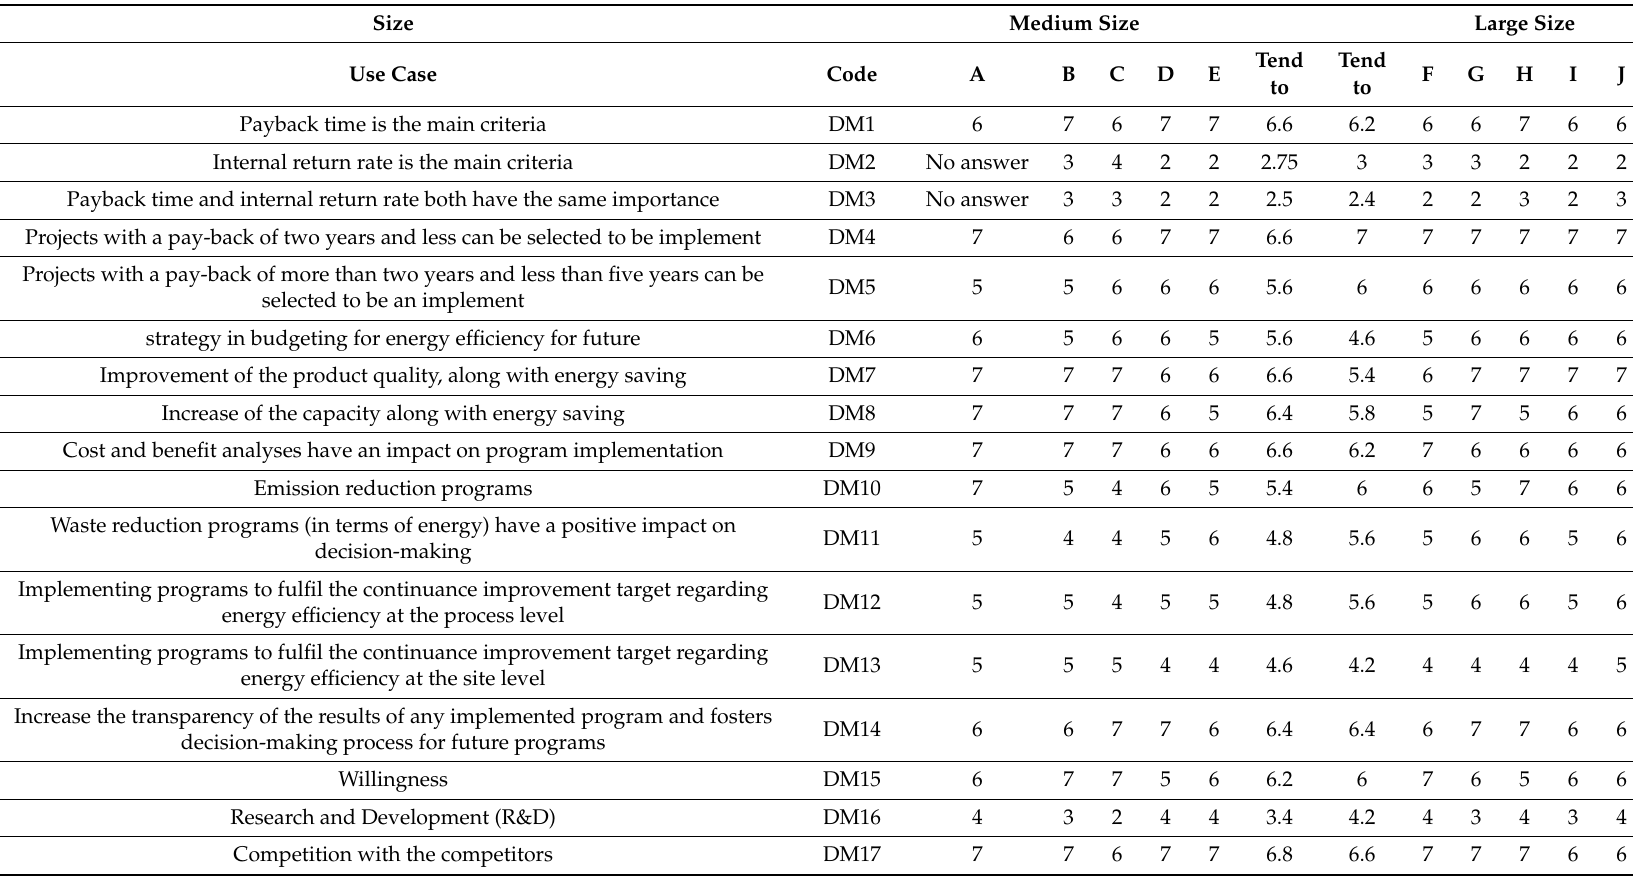
Table 3. Results for decision-making support and investment behavior (1 = not at all, 4 = moderately, 7 = great